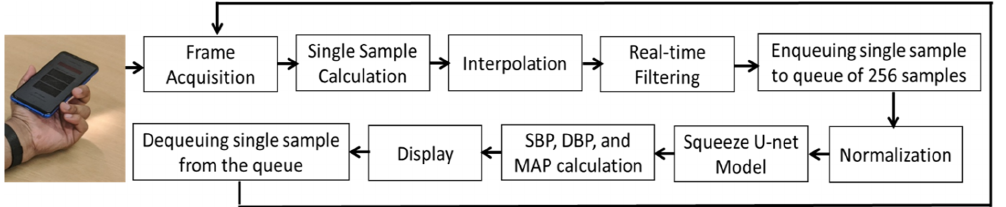
Figure 9. Implementation of real-time PPG signal filtering and BP values estimation.